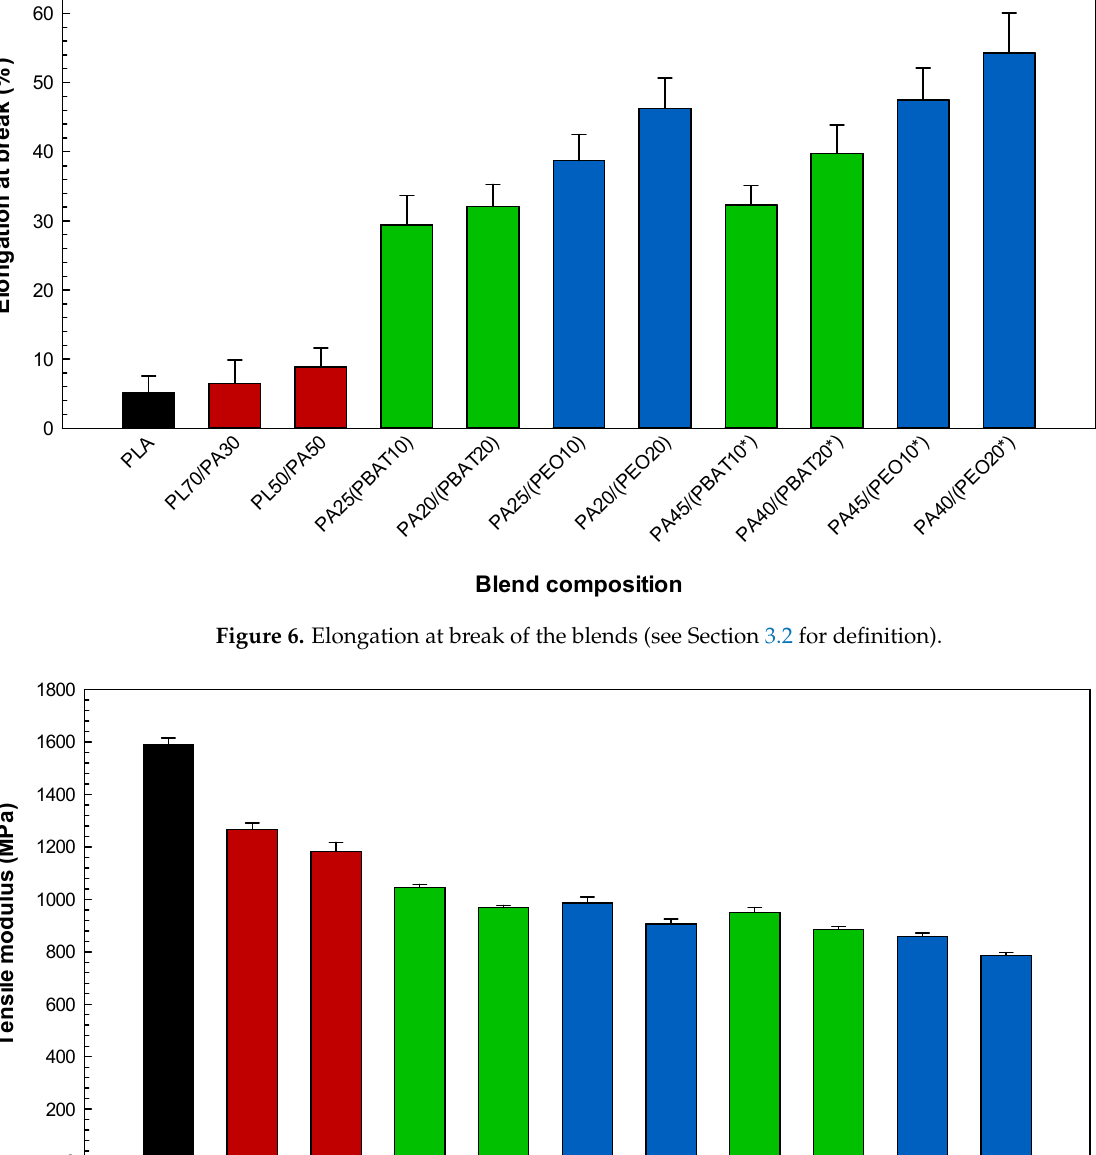
Figure 5. Tensile strength of the blends (see Section 3.2 for definition).